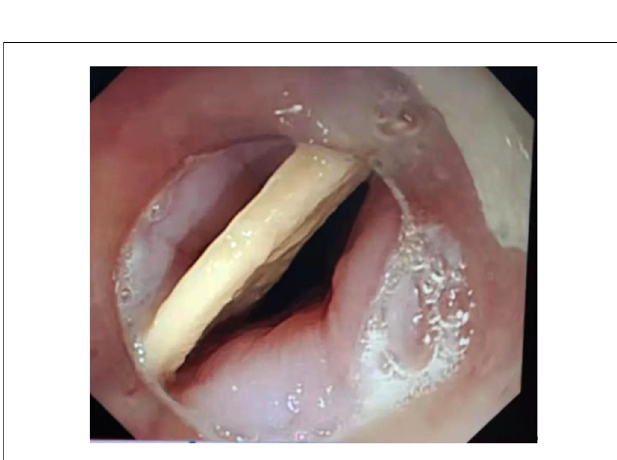
FIGURE 2 The fi shbone was 22 cm away from the incisors with both pointed ends punctured into the esophagus wall.